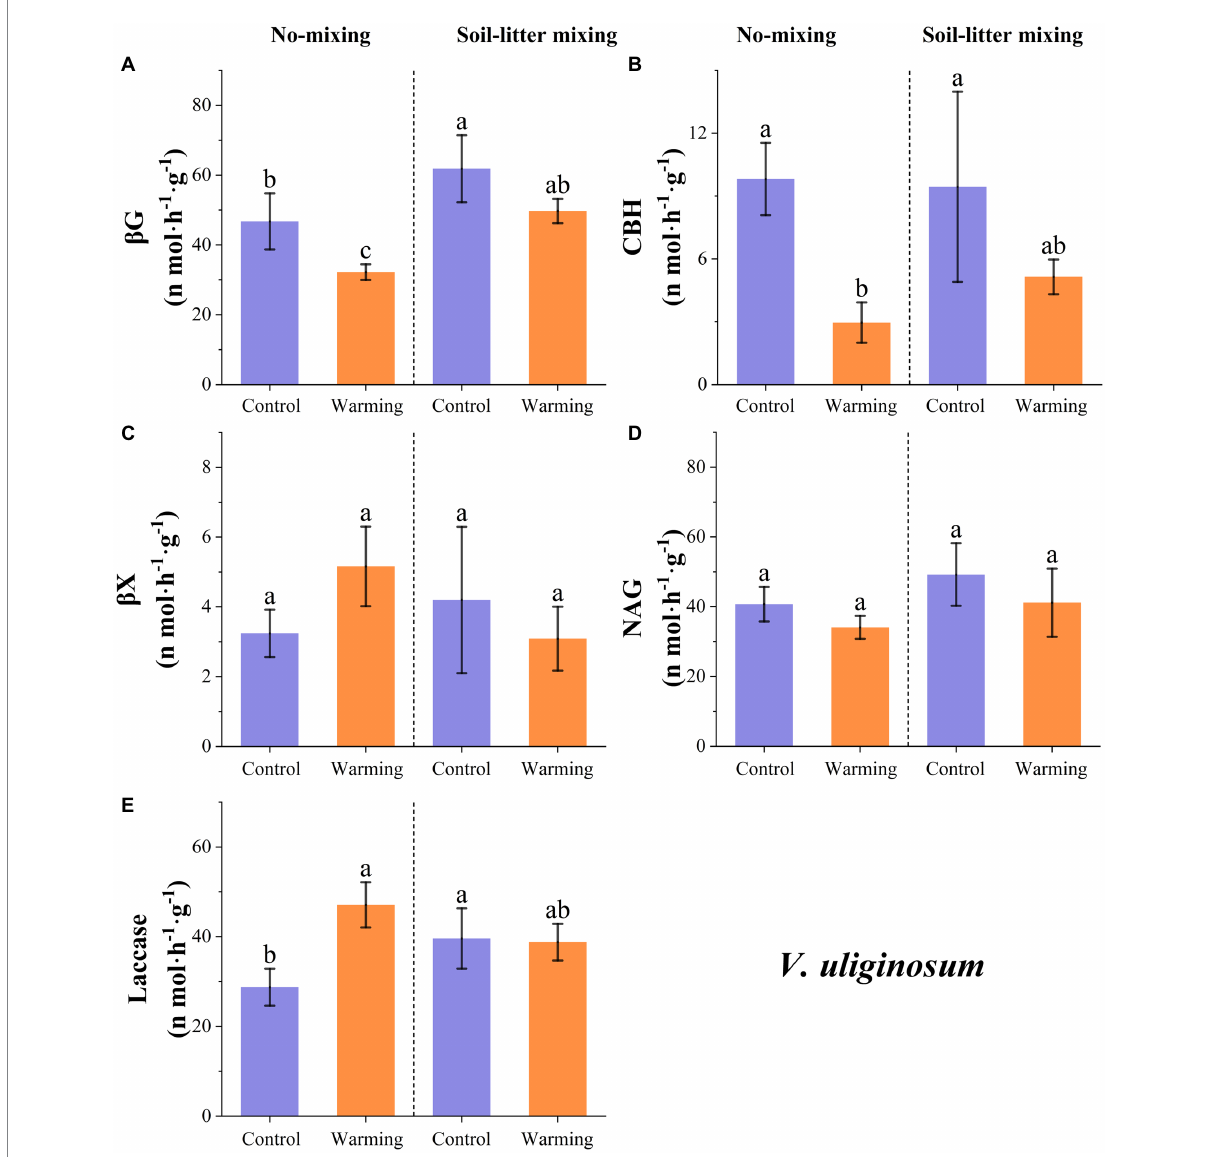
FIGURE 3 The responses of the potential enzyme activities of V. uliginosum to warming under the no-mixing and soil-litter mixing treatments. The enzymes are (A) β -glucosidase ( β G), (B) Cellobiohydrolase (CBH), (C) β -xylosidase ( β X), (D) N-acetyl-glucosaminidase (NAG), and (E) Laccase. The values are the mean ± standard deviation of each treatment ( n = 4). The different letters indicate significant differences ( p < 0.05) in the enzyme activities under the different